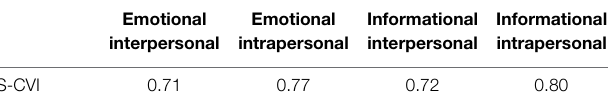
TABLE 2 | S-CVI/Ave scores for each